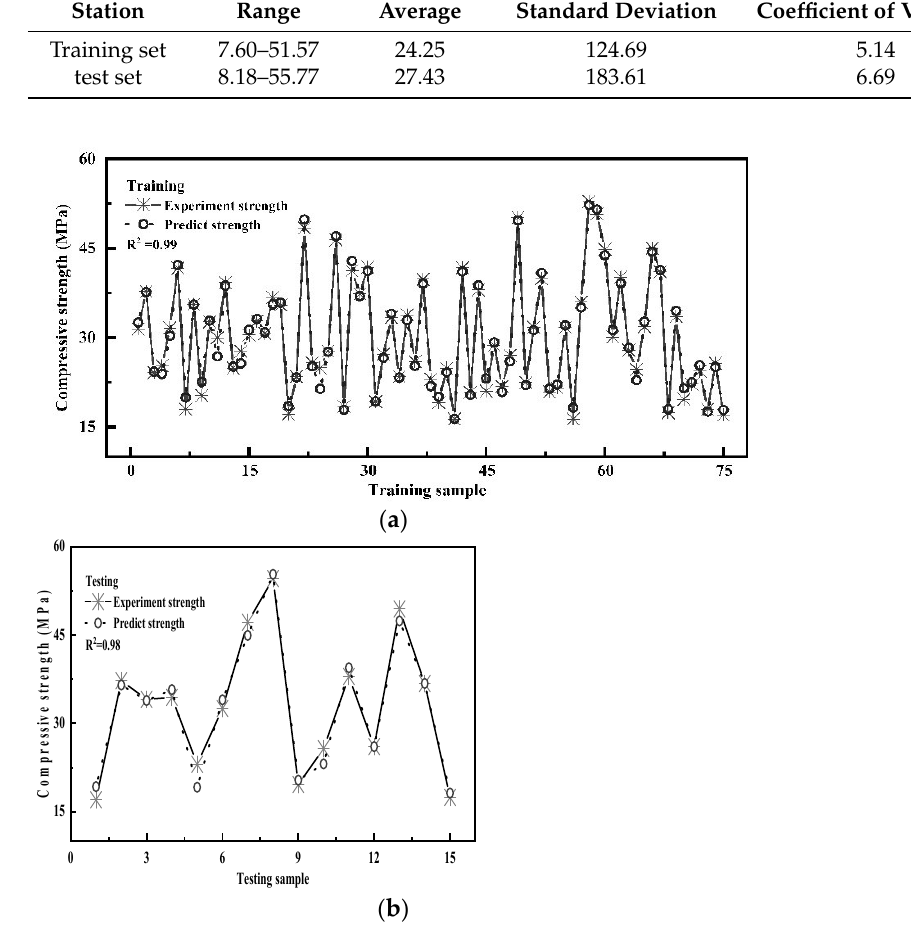
Figure 11. The results of training and testing. ( a ) Training sample; ( b ) Testing sample.